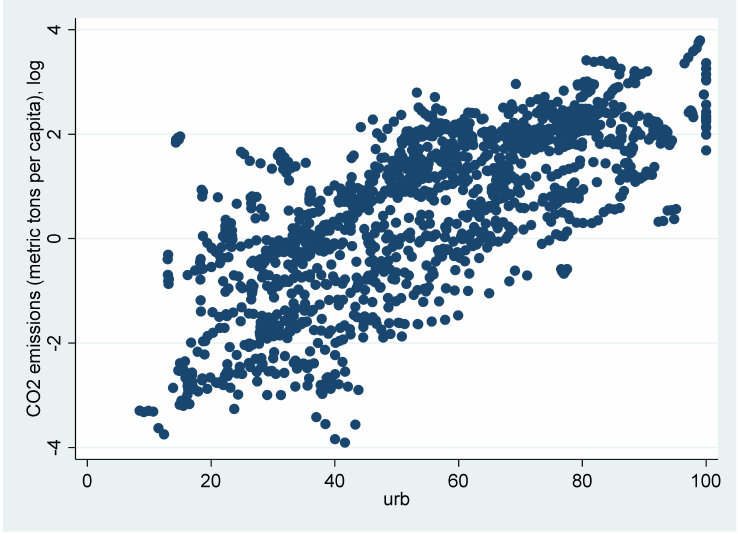
Figure 2. Scatter plot between urbanization and CO 2